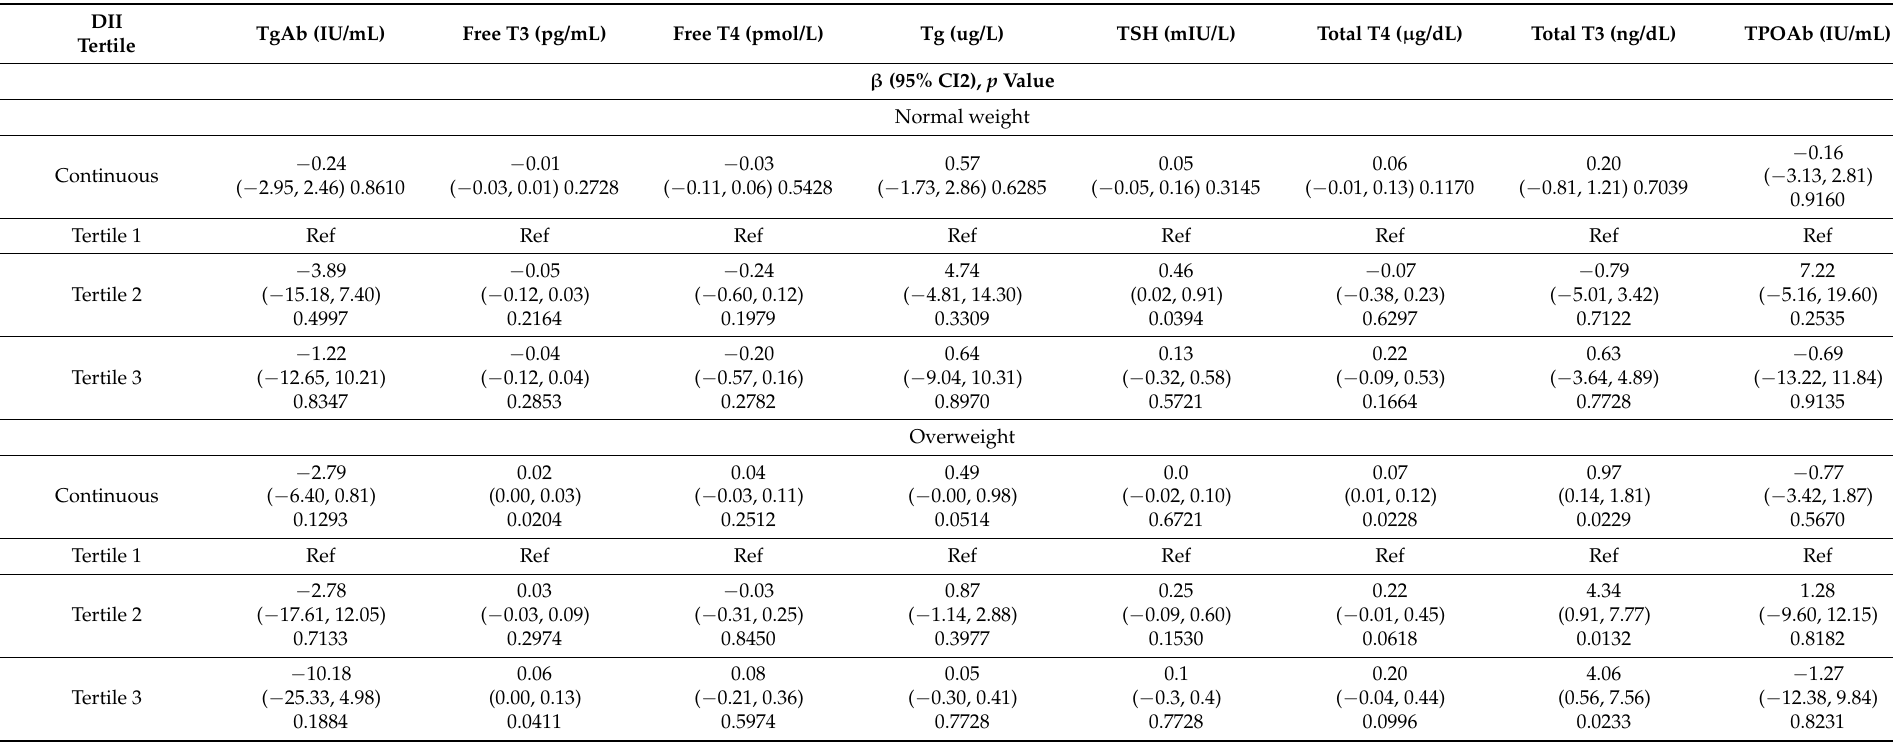
Table 3. Subgroup analysis of association between DII and thyroid function stratified by BMI groups among adult men in NHANES from 2007 to